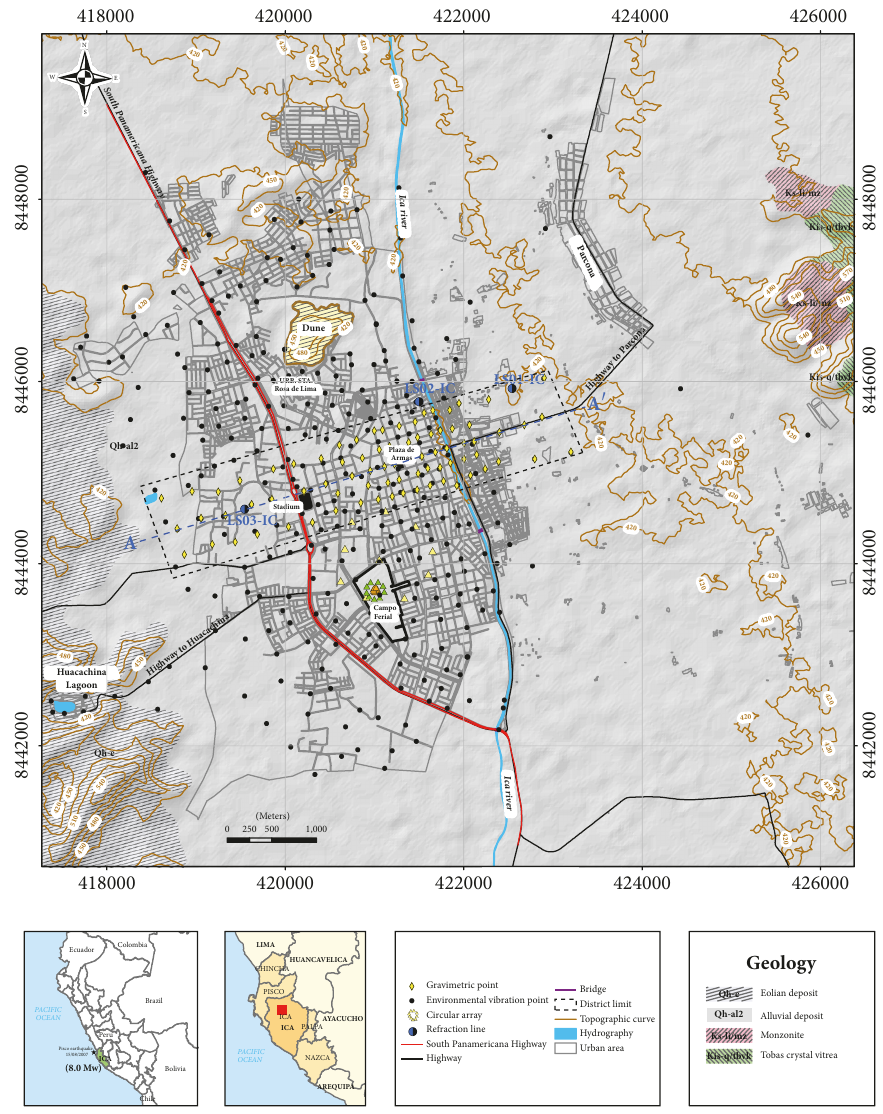
Figure 1: Geological setting of Ica, Peru. Black dots correspond to the locations of environmental vibration record, yellow diamonds correspond to gravimetric measurements, and yellow and green triangles correspond to circular seismic arrays. The LS01–LS03 line represents the linear seismic array. The A-A 󸀠 labels indicate the orientation of the gravimetric